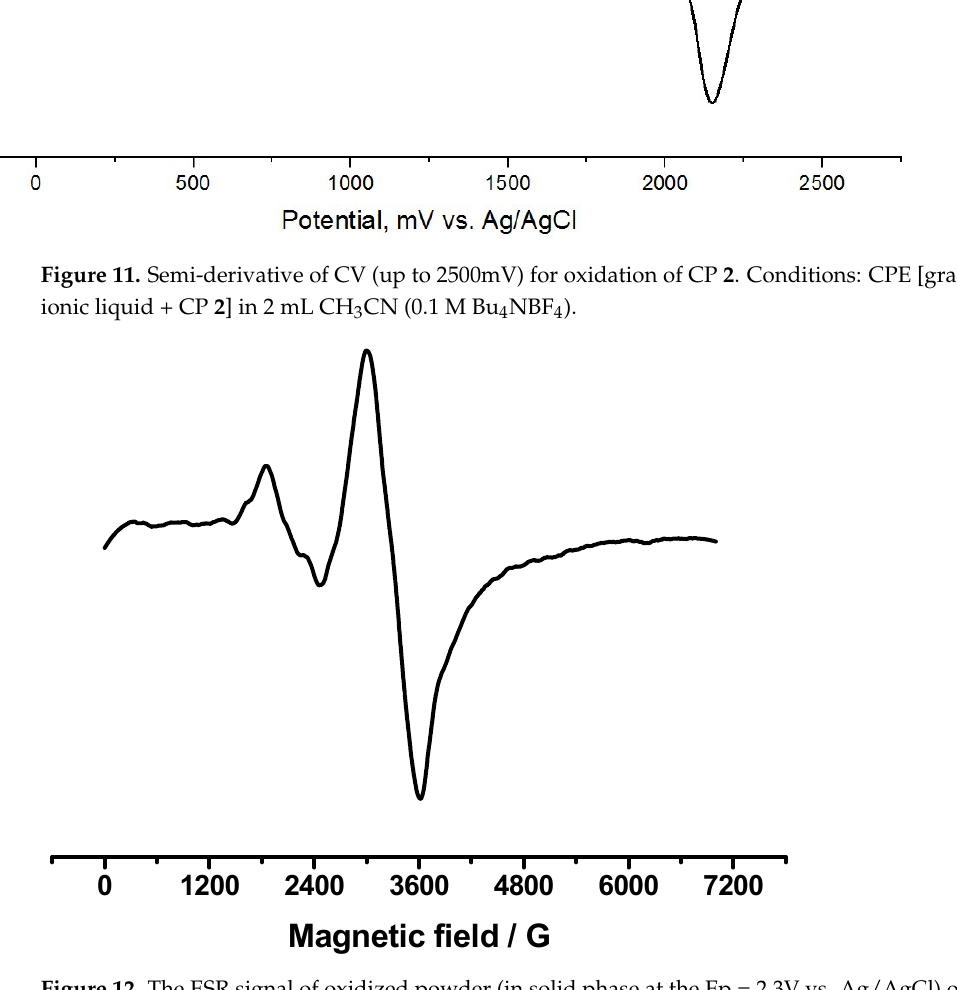
Figure 12. The ESR signal of oxidized powder (in solid phase at the Ep = 2.3V vs. Ag/AgCl) of CP 2